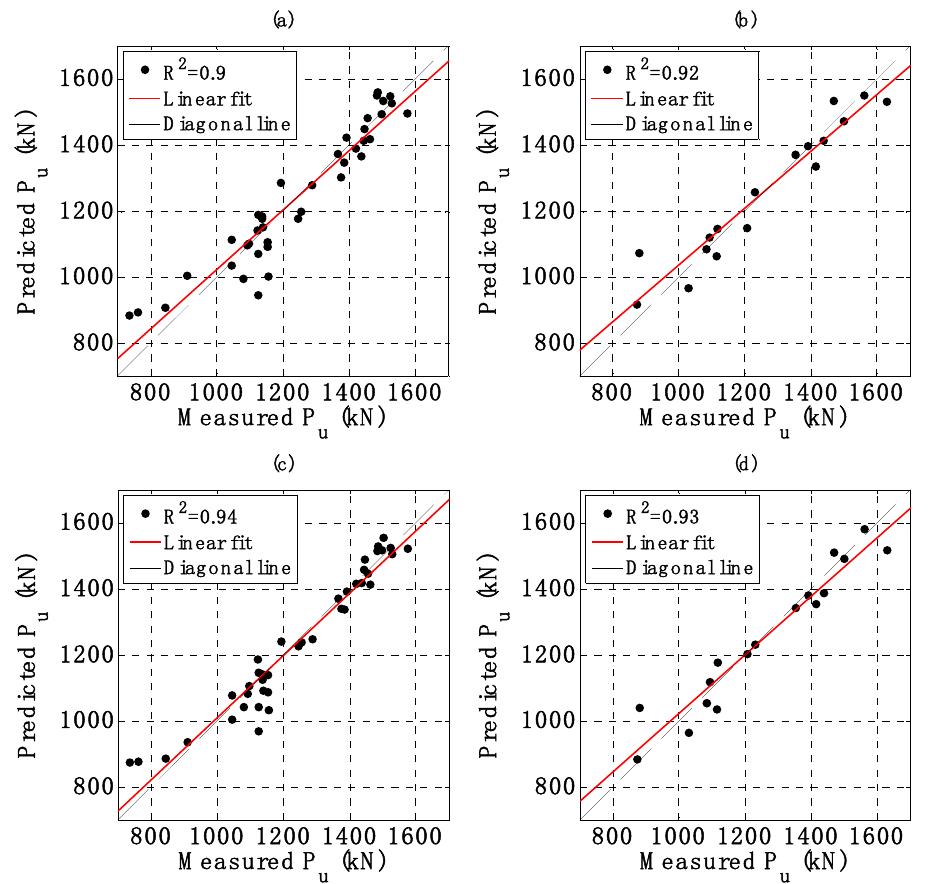
Figure 7. Regression results between measured Pu versus predicted Pu for the training part using ( a ) Adaptive Neuro-Fuzzy Inference System optimized by Genetic Algorithm (ANFIS-GA), ( c ) Adaptive Neuro-Fuzzy Inference System optimized by Particle Swarm Optimization (ANFIS-PSO); for the testing part using ( b ) ANFIS-GA, ( d ) ANFIS-PSO.